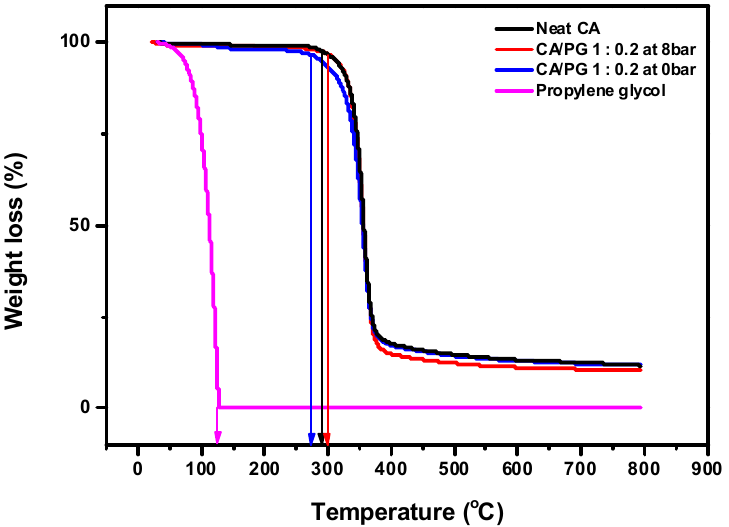
Figure 4. TGA of 1:0.2 CA/propylene glycol (8 bar, 0 bar), neat CA, and propylene glycol.